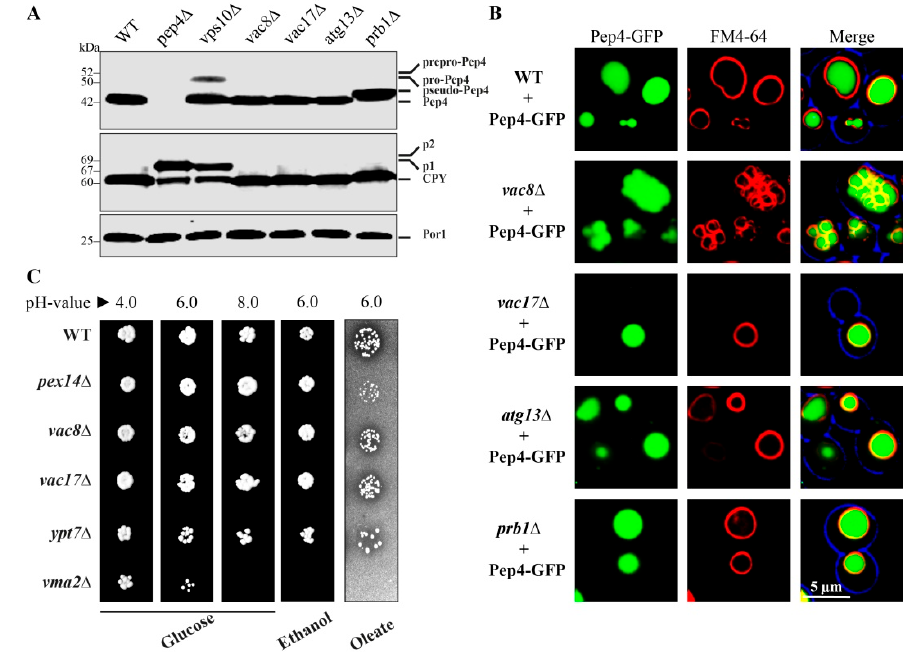
Figure 1. Maturation of the vacuolar proteases Pep4 and Cpy1 is independent of Vac8. ( A ) Fully maturated Pep4 and Cpy1 can be detected in the lysates of wild-type (WT) cells. Non-maturated species can be detected in vps10 Δ cells, which lack the main trafficking receptor for Pep4 and Cpy1. The strain deleted for the protease Prb1 shows the known pseudo-Pep4, while Cpy1 also displays a species of higher molecular weight. Pep4 and Cpy1 are fully maturated in vac8 Δ , vac17 Δ , and atg13 Δ cells. ( B ) The vacuolar targeting of Pep4-GFP was monitored via the fluorescence microscopy. Pep4-GFP shows a WT-like localization within the lumen of the FM4-64-stained vacuole in vac8 Δ , vac17 Δ , atg13 Δ , and prb1 Δ cells. ( C ) Vac8 is not involved in the acidification of the vacuole. Vma2 is the subunit B of the V1 peripheral membrane domain of the vacuolar H + -ATPase. Therefore, the vma2 Δ strain does not grow on pH = 8.0 plates. In contrast, vacuolar acidification is not disturbed in WT, vac8 Δ , vac17 Δ , and ypt7 Δ cells. Vac8 is also not essential for the biogenesis of mitochondria and peroxisomes.